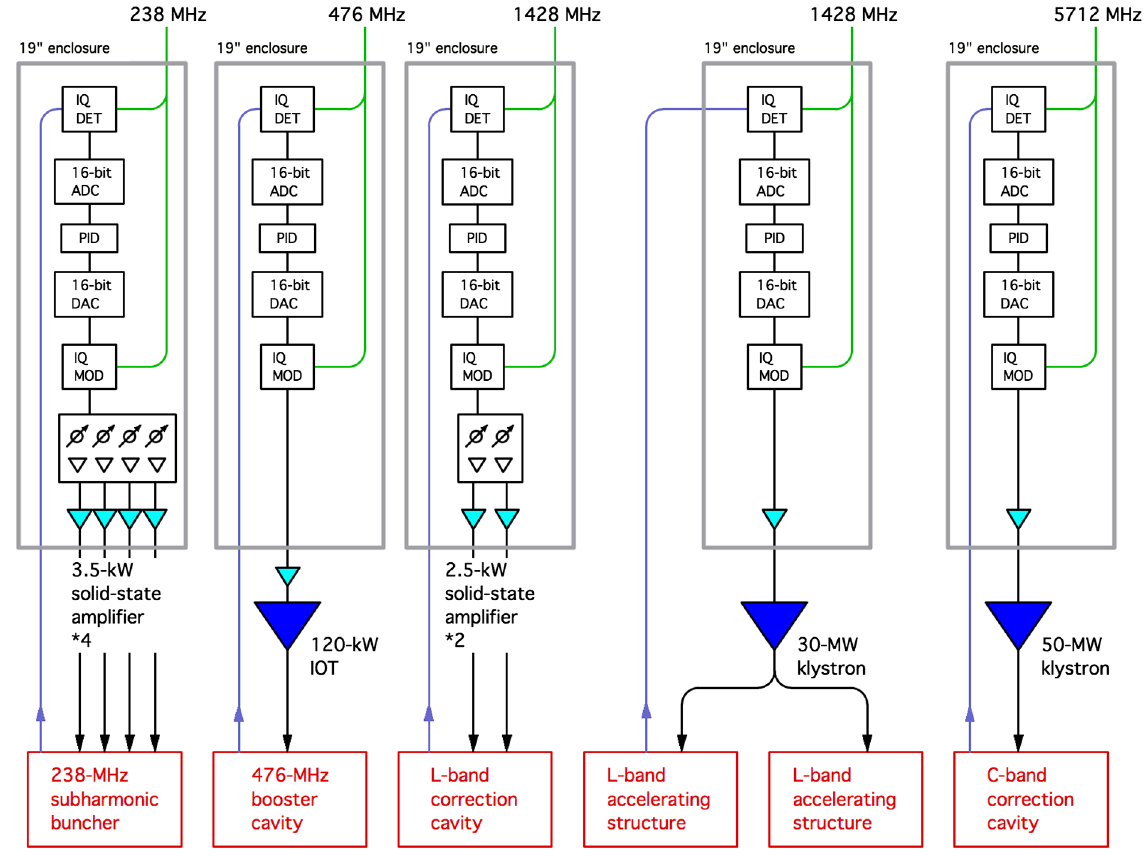
FIG. 7. rf block diagrams of the SACLA injector. IQ MOD and IQ DET indicate the IQ modulator and IQ detector, respectively. PID indicates the proportional-integral-derivative controller. The 476-MHz rf signal is amplified by a 120-kW inductive output tube